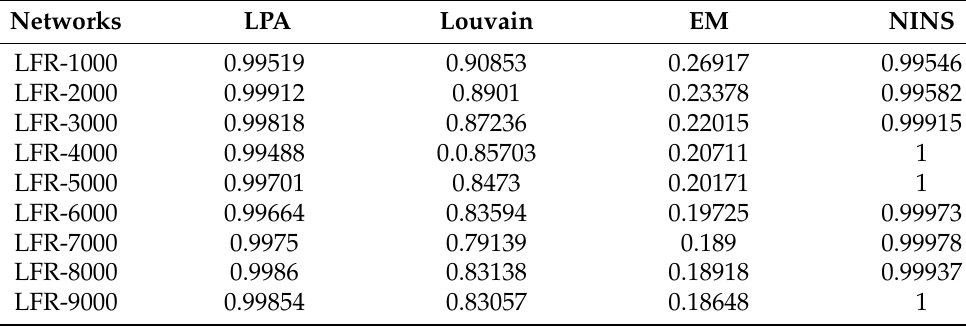
Table 7. The NMI of four methods in nine LFR